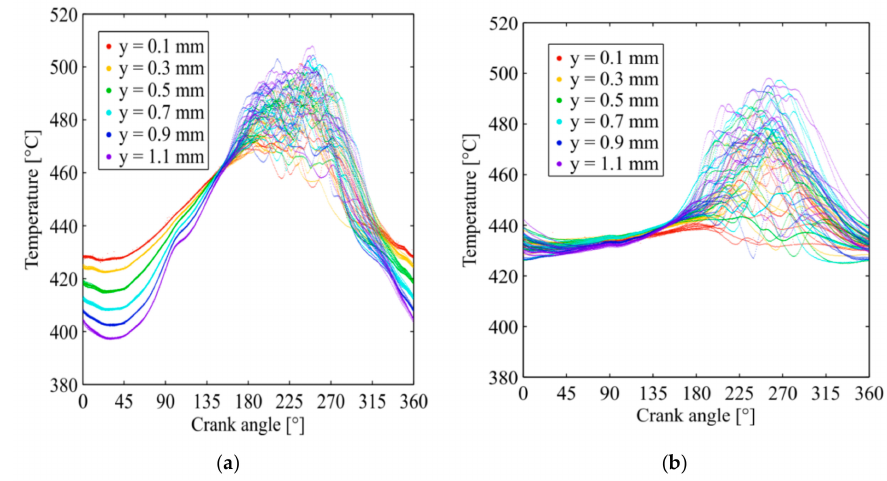
Figure 9. Gas temperatures in Vuilleumier mode at the open end (probe a) at nominal conditions except p = 20 bar: ( a ) old seal design [32]; ( b ) new seal